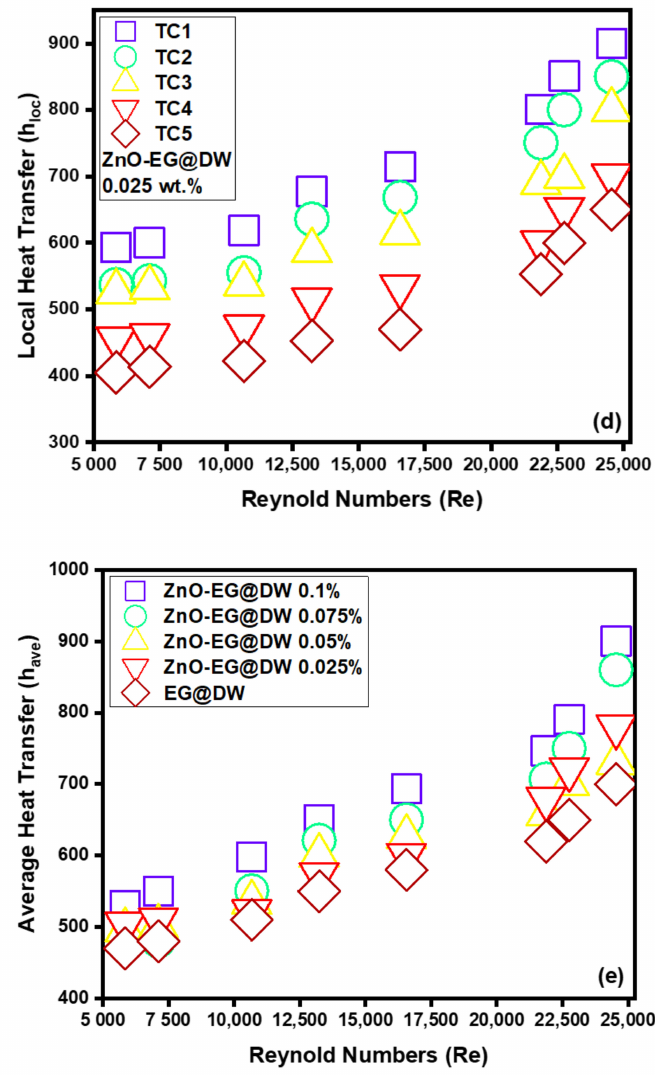
Figure 13. ( a ) Local heat transfer for 0.1 wt.%, ( b ) local heat transfer for 0.075 wt.%, ( c ) local heat transfer for 0.05 wt.%, ( d ) local heat transfer for 0.025 wt.% and ( e ) average Heat transfer for each wt.% of ZnO-EG@DW nanofluids and EG@DW at Reynolds number 5849 to